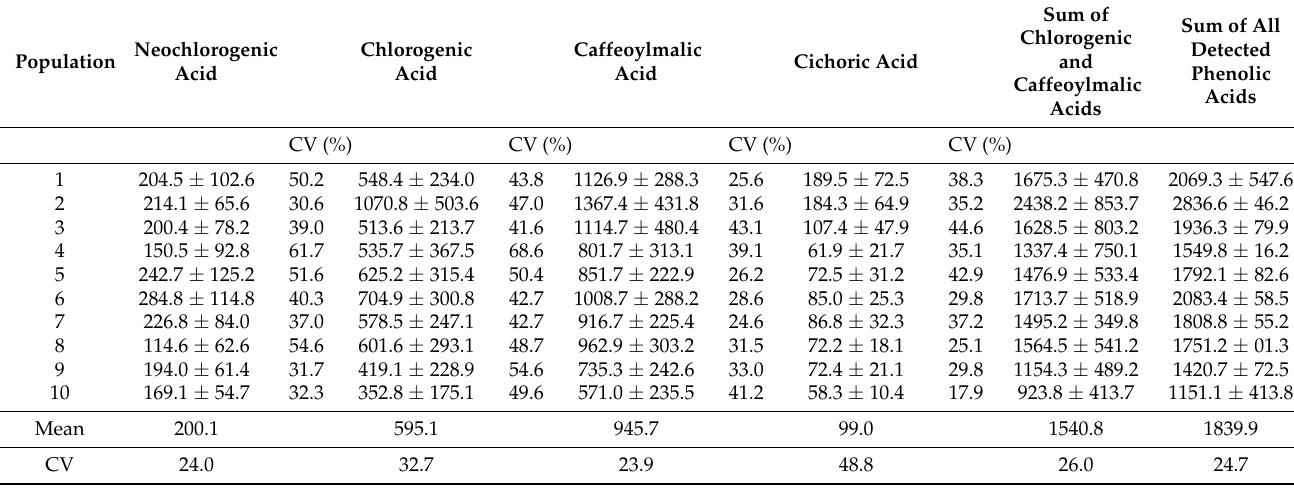
Figure 3. Chemical structures of identified phenolic compounds: ( 1 ) neochlorogenic acid, ( 2 ) chlorogenic acid, ( 3 ) caffeoylmalic acid, ( 4 ) rutoside, ( 5 ) hyperoside and ( 6 ) cichoric acid.